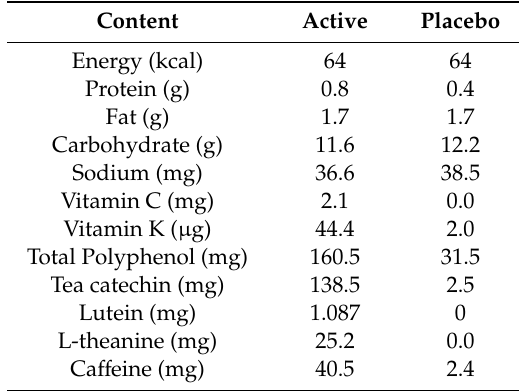
Table 1. Composition of the Active drink with Matcha green tea powder and placebo